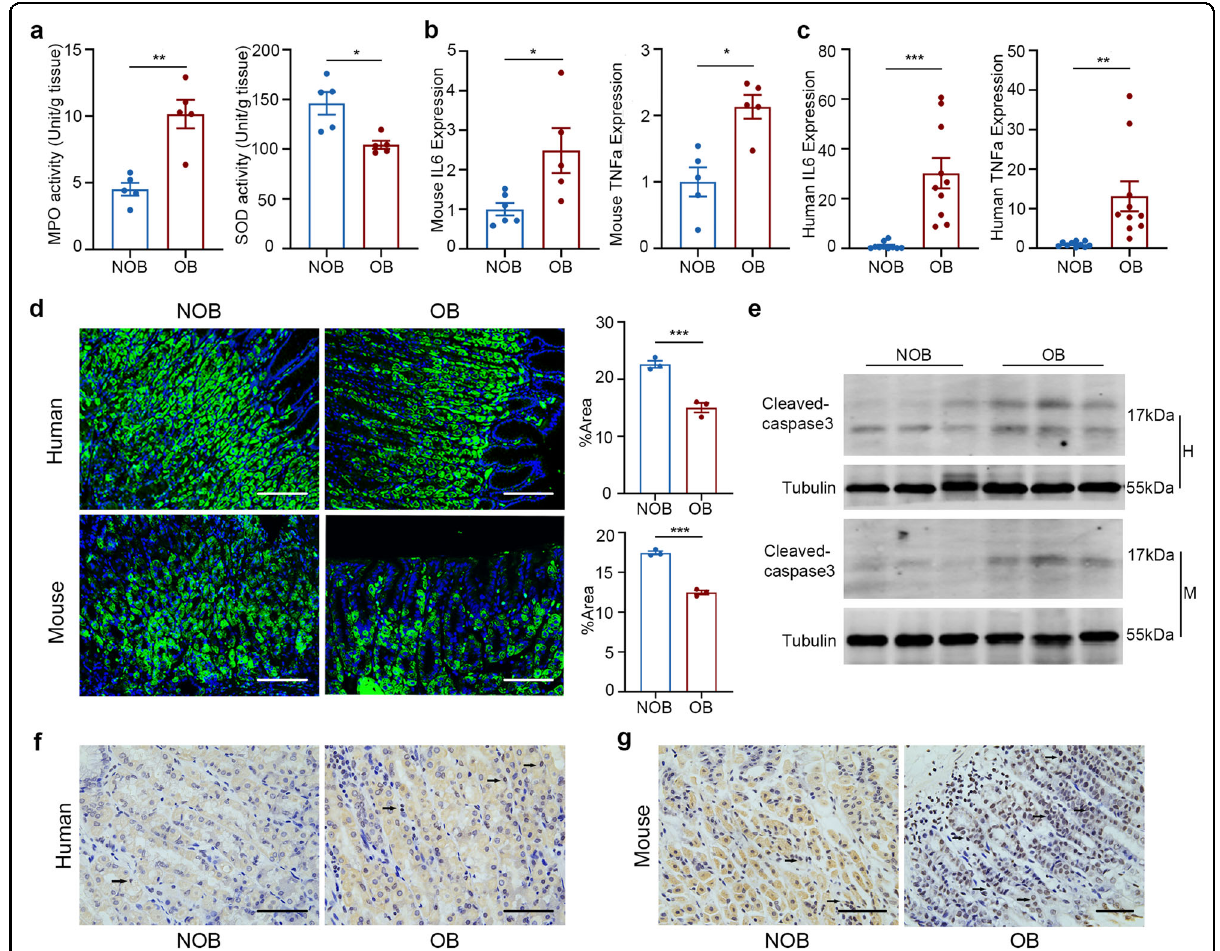
Fig. 2 Gastric mucosa was injured in obese group. a Increased oxidative stress in obese state. n = 5 mice/group. Expression of pro-in fl ammatory genes in gastric mucosa of mice ( b ) n = 5 mice/group and humans ( c ) n = 10 patients/group. d Immuno fl uorescence staining of parietal cells (green) on stomach tissue sections (×10, ×20 magni fi cation; 100 µm scale bar). e Western blot analysis of cleaved caspase-3. Tubulin was used as a loading control. Detection of TUNEL-positive cells in stomach tissue in humans ( f ) and mice ( g ) via TUNEL staining, the arrow in the image refers to the apoptotic cells (×40 magni fi cation; 100 µm scale